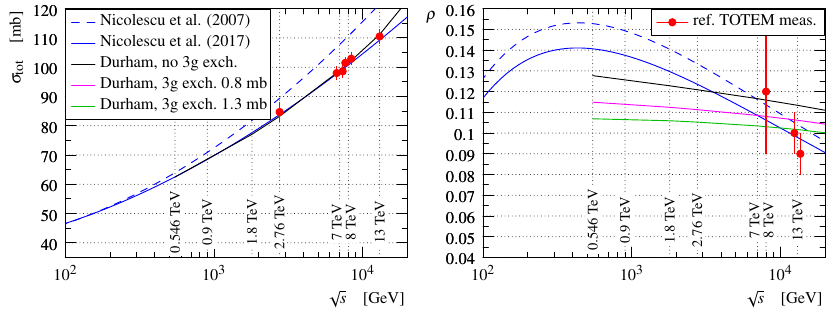
Figure 3. Measured values of σ tot and ρ are compared to two di ff erent class of model calculations. The comparisons indicate that with an Odderon contribution, the recent TOTEM data for the pair of ( σ tot ,ρ ) at √ s = 13 TeV can be described simultaneously: Predictions of the Odderon model by Nicolescu and collaborators are shown by a dashed [18] and solid blue curves [19]. Results from the KMR model [20] without Odderon e ff ects are shown with a black line, and with Odderon e ff ects are shown with magenta and green lines, where the crossing-odd contribution is taken from ref. [21]. Reference TOTEM measurements are indicated by red